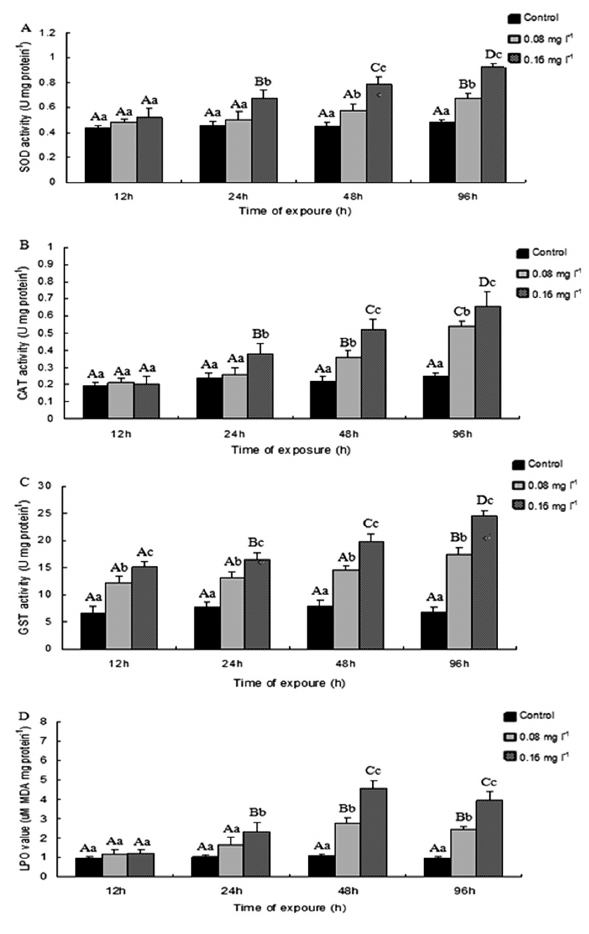
Fig. 2. – Superoxide dismutase (SOD) activity (A), catalase (B) activity, glutathione S-transferase (GST) activity (C) and lipid peroxidation (LPO) value (D) in megalopa larvae after copper treat- ment (0, 0.08 mg L –1 , 0.16 mg L –1 ). Values are means ±SE ( n =4). Bars sharing different letters in each index are significantly different (P<0.05). Different lowercase letters indicate significant differences between the treatment and control groups for each exposure time. Different capital letters indicate significant differences between dif- ferent exposure times for the same copper